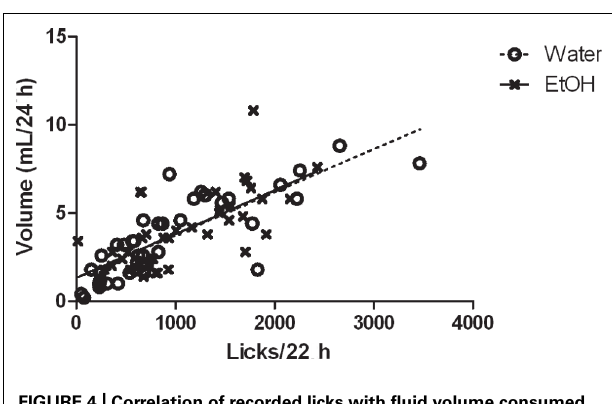
FIGURE 4 | Correlation of recorded licks with fluid volume consumed. The relationship between the number of recorded licks from each drinking tube on the X -axis with the volume of water (O) or ethanol (X) consumed on the Y -axis, for each of 4 days in isolation is graphed for one cohort of animals ( n = 10) representative of the entire experiment.There was a strong positive correlation for both water ( r = 0.815, n = 40, p < 0.0001) and ethanol ( r = 0.694, n = 40, p < 0.0001).